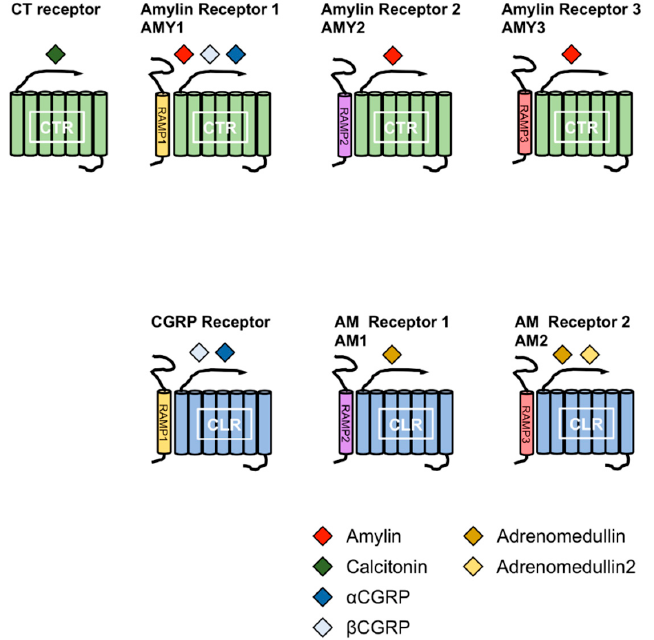
Figure 2. Combination of receptor activity-modifying proteins ( RAMPs) and calcitonin receptor ( CTR) or CLR leads to the formation of different receptors for calctionin, CGRPs, amylin and adrenomedullins. The CT family comprises amylin, calcitonin (CT), α calcitonin gene-related peptide ( α CGRP), β CGRP, adrenomedullin (AM) and AM2. The combination of RAMPs and CTR or CTR-like receptor (CLR) leads to the formation of different receptors for the members of the CT family. Amylin receptors include AMY 1 , AMY 2 and AMY 3 receptors comprising the CTR complex to RAMP1, RAMP2 and RAMP3, respectively.